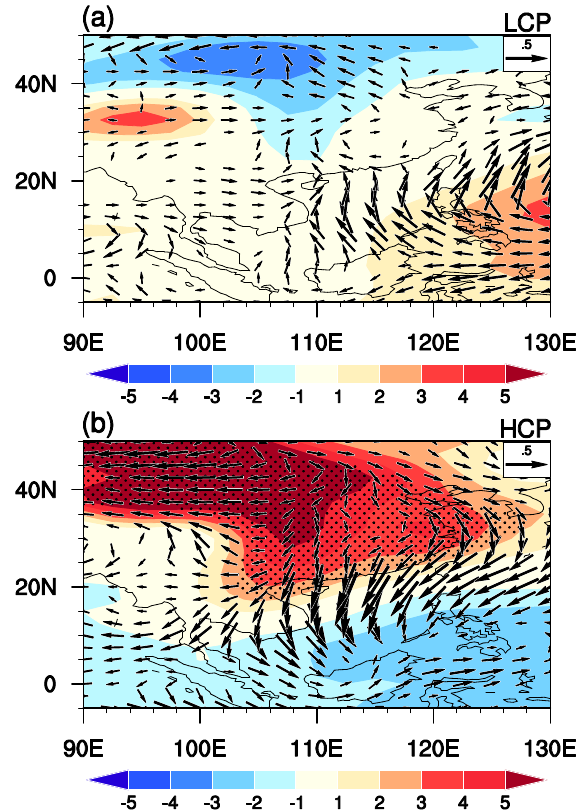
Figure 5. Anomalies of boreal winter winds (vectors; m s − 1 ) and geopotential height (shadings; m) at 1000 hPa regressed upon the standardized winter AO index during ( a ) 1972–1987 and ( b ) 1997–2012. Stippled regions in ( a )–( b ) denote geopotential height anomalies significant at the 5% level.